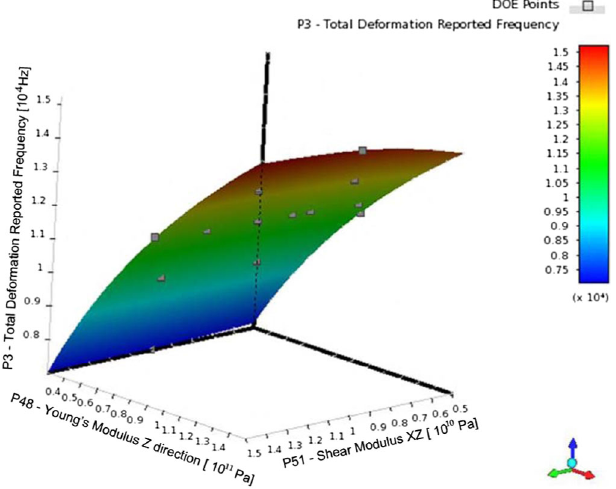
FIG. 21. 3D response surface for E against flexural frequency